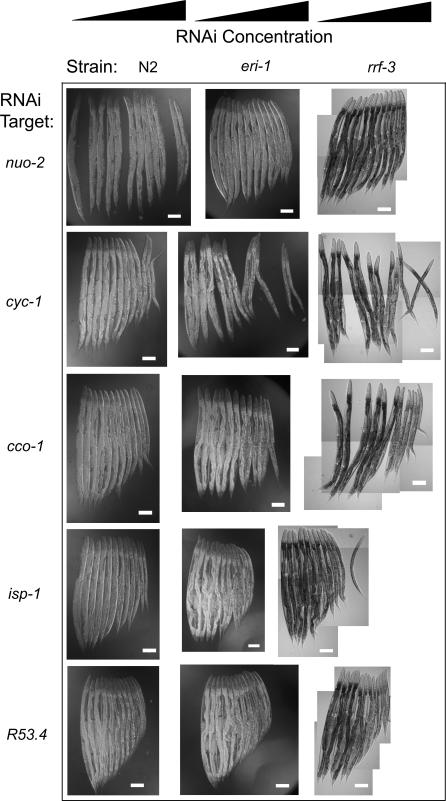
Adult Size Decreases with Increasing Mit Mutant RNAi ConcentrationRNAi dilution series for nuo-2, cyc-1, cco-1, isp-1, and R53.4 were established using N2 (left column), eri-1(mg366) (middle column), and rrf-3(pk1426) (right column) animals. When vector-only treated animals became 1-d-old gravid adults, individual worms were randomly selected from each RNAi dilution and mounted for Normaski imaging (400×): left to right (target gene to empty vector ratio), 0:1, 1:1,000, 1:750, 1:500, 1:200, 1:100, 1:50, 1:20, 1:10, 1:5, 1:2, and 1:0. Scale bars indicate 100 μm.